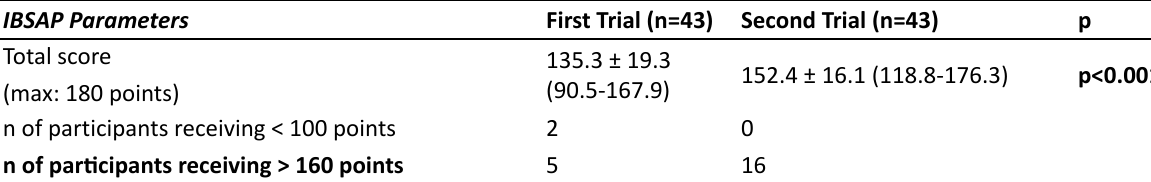
Table 5. Results obtained in IBSAP with all balls in first and second